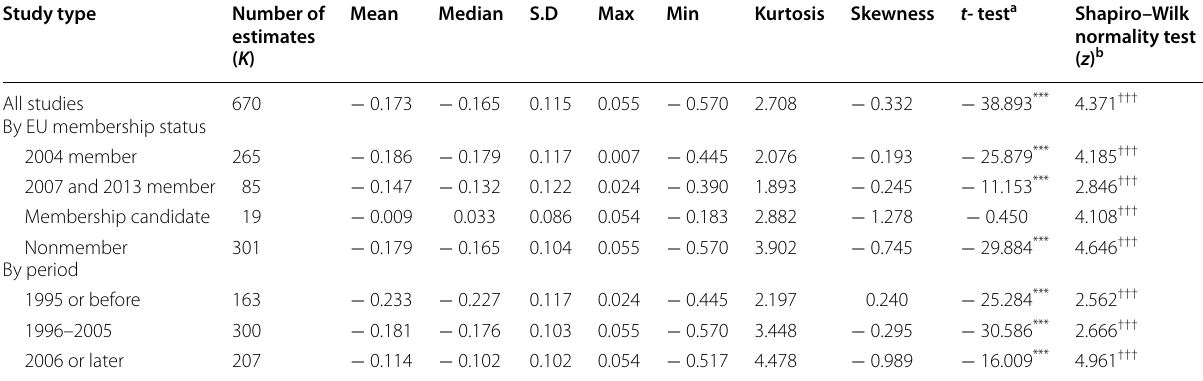
This table shows the number of estimates of the gender dummy variable in the Mincer-type wage function estimated in 53 research works listed in Additional file 1: Table S1 and Additional file 2: Bibliography of studies subject to meta-analysis Descriptive statistics of the estimates and the results of t -test and Shapiro-Wilk normality test are also reported for all studies and by EU membership status and estimation